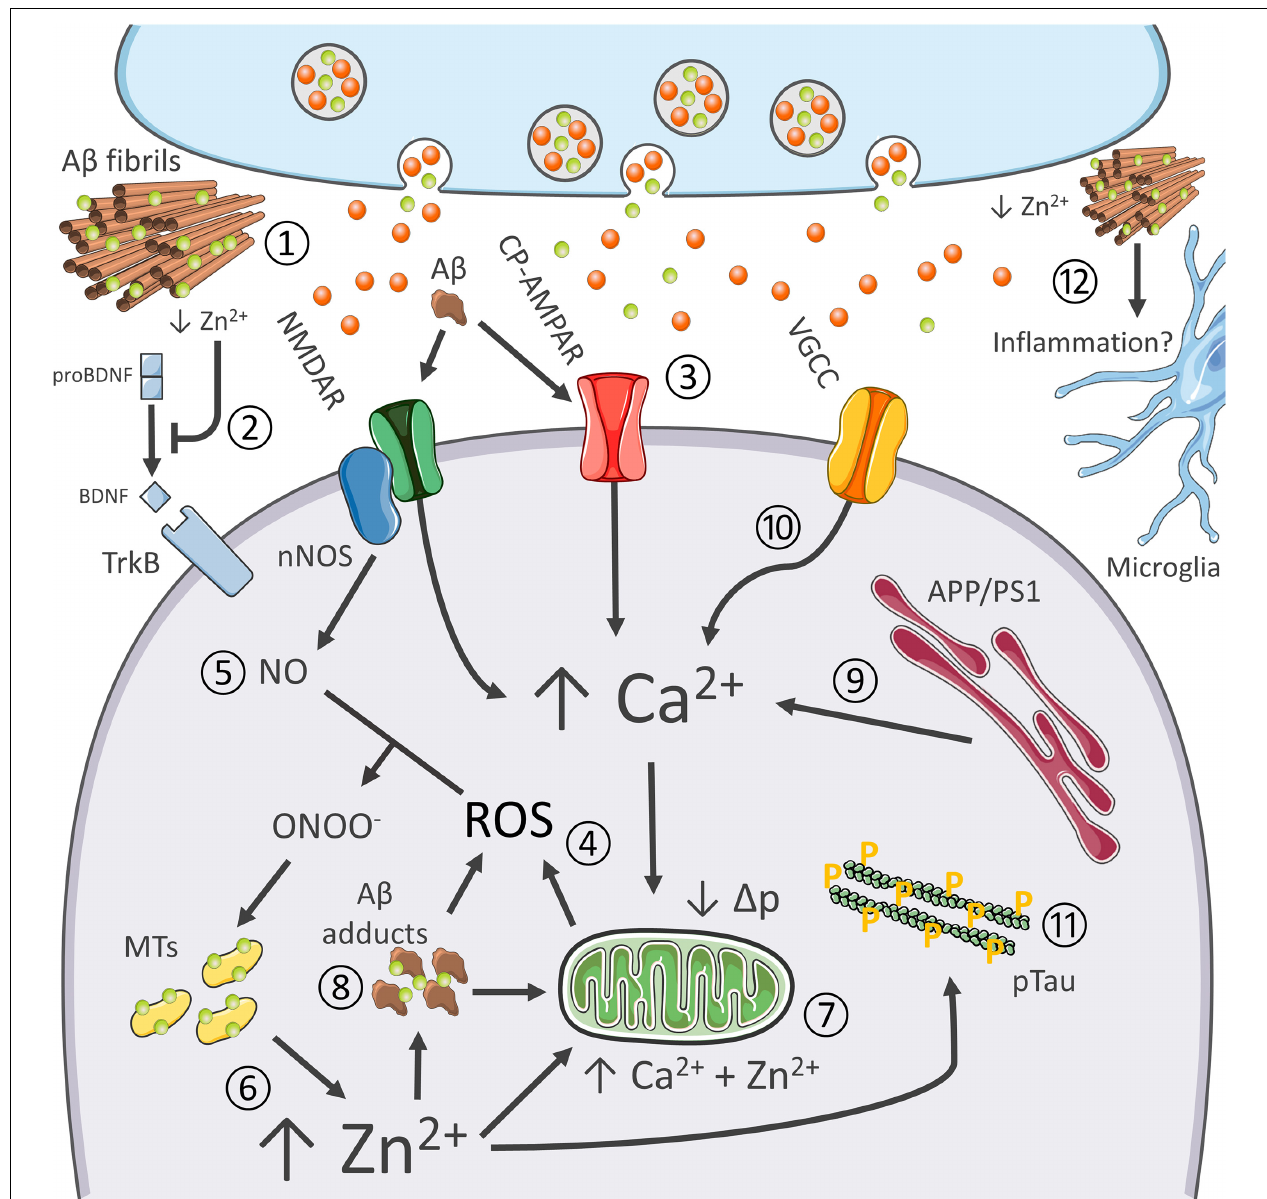
FIGURE 2 | Synergistic contribution of A β and tau pathology, oxidative stress, excitotoxicity, Ca 2 + dysregulation, and inflammation in AD. Role of Zn 2 + in the process. The pictogram summarizes the synergistic interaction between AD-related molecular changes, and the cation dysregulation triggered by altered glutamatergic neurotransmission. Aberrant glutamatergic signaling represents a critical point of convergence of many of the molecular changes observed in AD. A β avidly sequesters synaptically released Zn 2 + into senile plaques (1). Cation removal from the cleft negatively affects BDNF maturation and, therefore, impinges on neurotrophic signaling (2) as well as Zn 2 + -dependent NMDAR blockade. A β adducts can also directly activate NMDARs and CP-AMPARs, thereby further promoting the glutamatergic overdrive (3). NMDAR and CP-AMPAR overactivation promotes Ca 2 + accumulation, increase the intracellular production of ROS (4), as well as the generation of nitric oxide (NO) from nNOS (5). ROS and RNS species are instrumental for Zn 2 + release from MTs (6). Zn 2 + build-up is potently neurotoxic as the cation, in synergy with Ca 2 + , further promotes mitochondrial dysfunction, ROS generation, and the release of apoptotic molecules (7). Zn 2 + rises may also trigger intraneuronal A β aggregation (8). A β adducts may further contribute to mitochondrial impairment and generation of ROS. AD-related mutations on PS1 and APP and oxidative stress enhance Ca 2 + dyshomeostasis by altering cation handling by the ER (9) and influx through VGCC (10). Ca 2 + and Zn 2 + rises, along with oxidative stress, also promote tau hyperphosphorylation (11). Finally, recent findings pinpoint at Zn 2 + as a critical modulator of neuroinflammatory processes